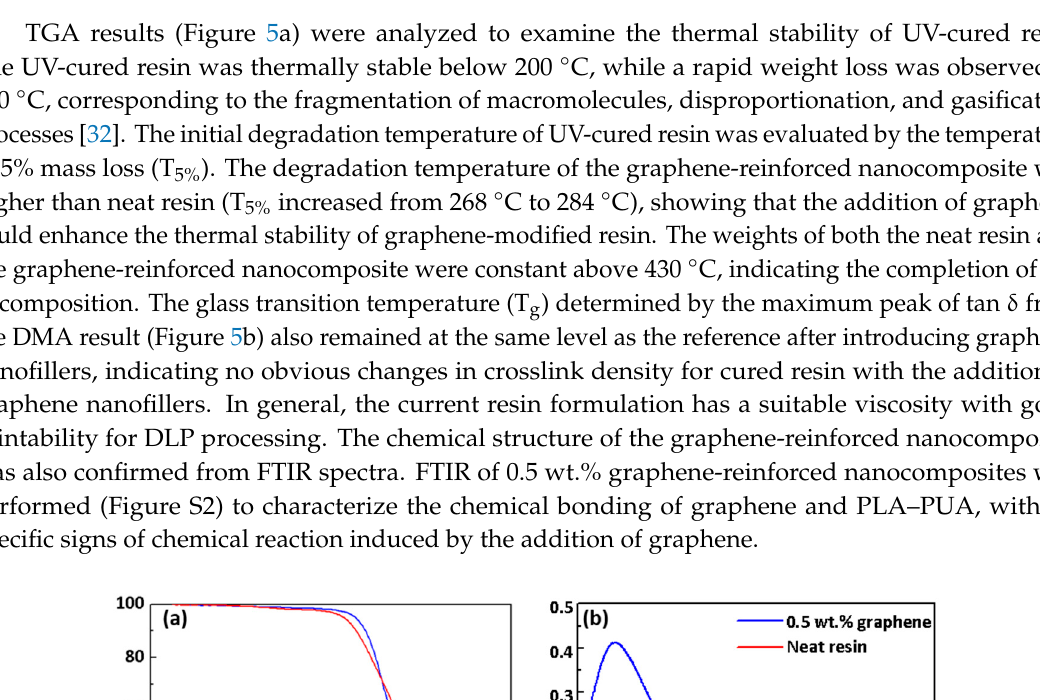
Figure 4. Contact angle images of ( a ) the liquid neat resin (around 20°) and ( b ) liquid 0.5 wt. % graphene-reinforced resin (around 30°) on a glass substrate. Water contact angle images of UV-cured ( c ) neat resin and ( d ) 0.5 wt. % graphene-reinforced resin.